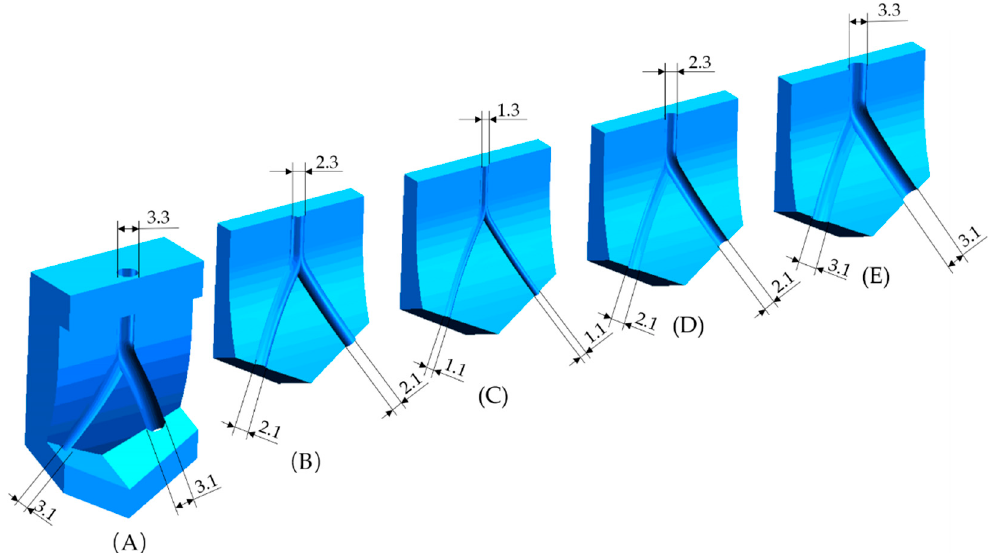
Figure 4. Mold system: ( A ) mold 1; ( B ) mold 2; ( C ) mold 3; ( D ) mold 4; and ( E ) mold 5.